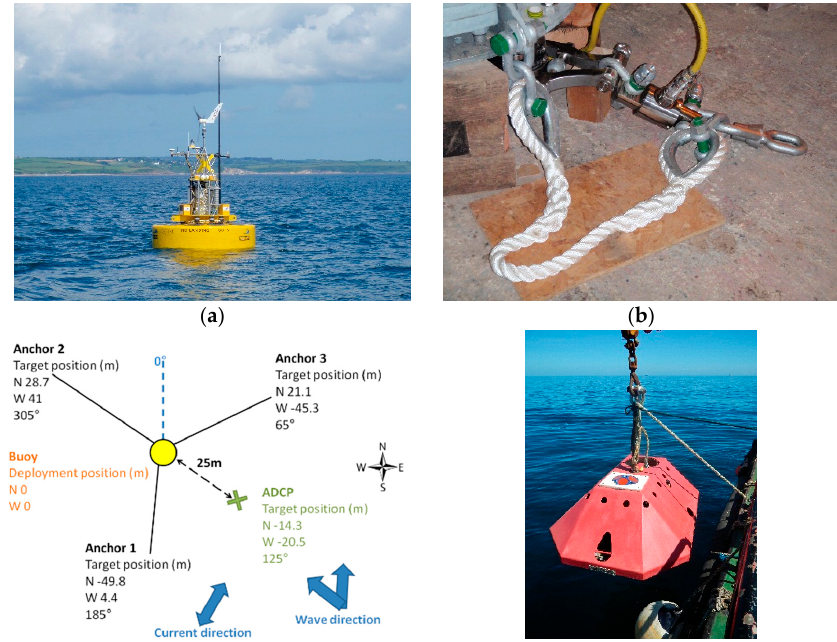
Figure 2. SWMTF arrangement and instrumentation: ( a ) buoy; ( b ) tri-axial (left) and axial (right) mooring load cells and back-up rope (white); ( c ) plan view layout of the mooring system and ADCP (wave and current sensor) and ( d ) ADCP in its frame being